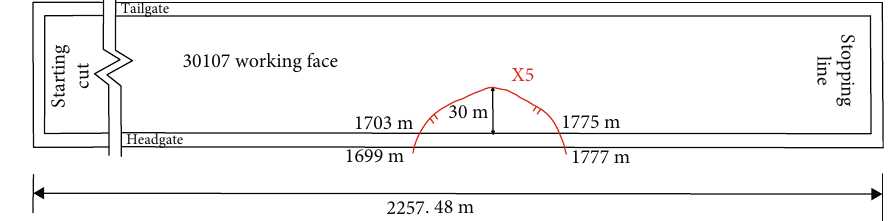
Figure 1: Plane position of the X5 FCC.